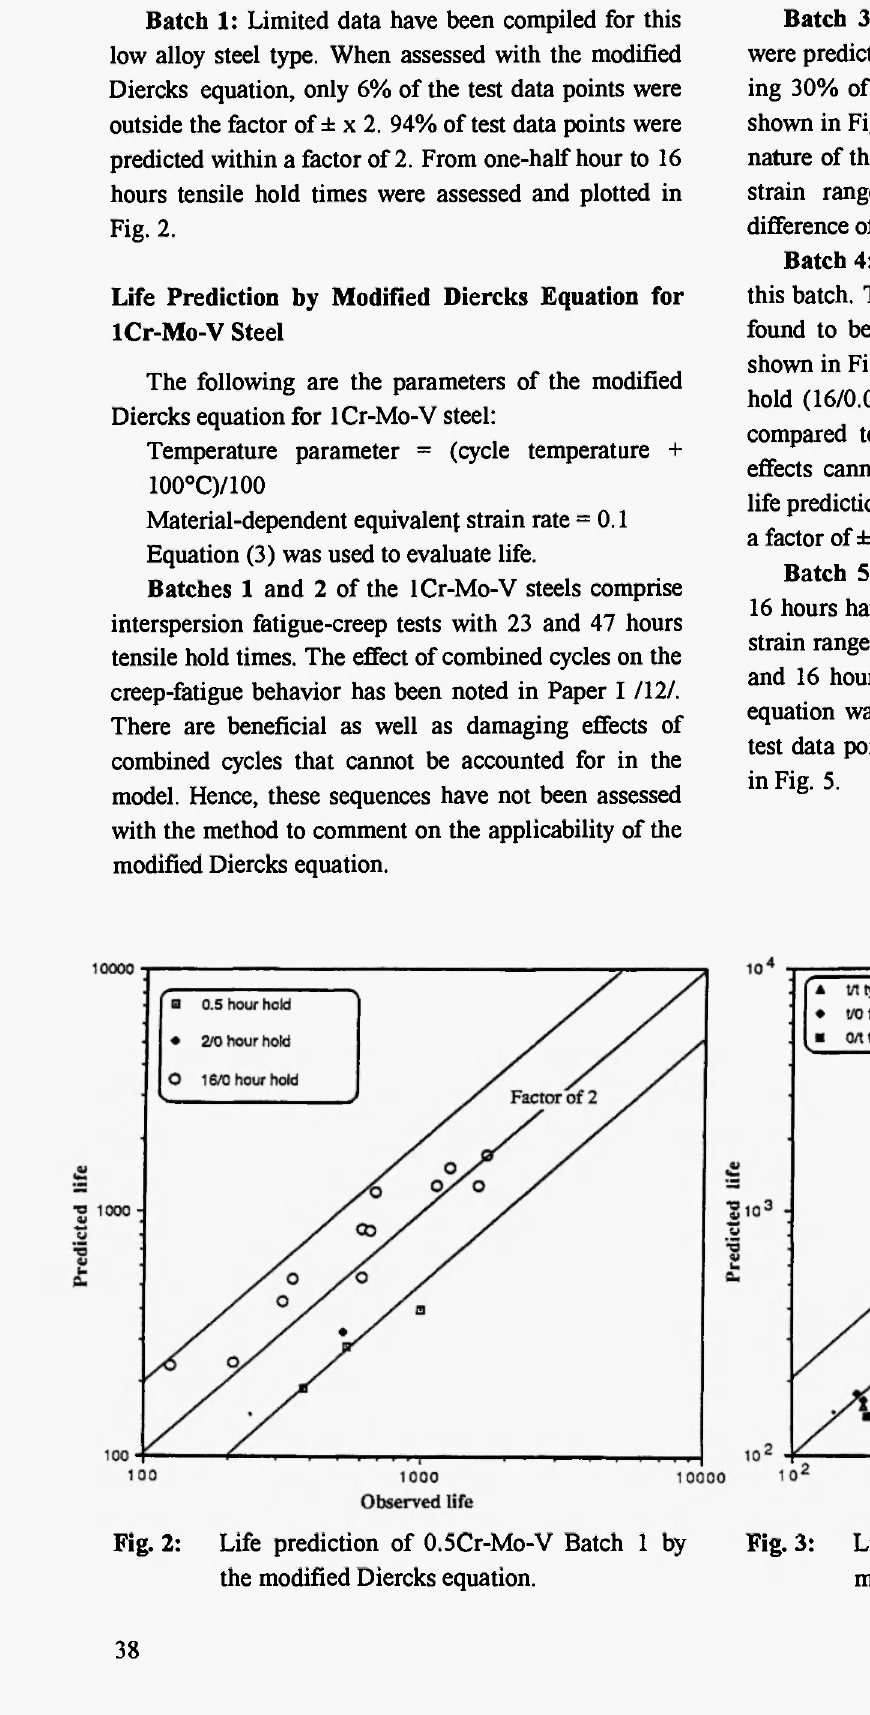
Fig. 2: Life prediction of 0.5Cr-Mo-V Batch 1 by Fig. 3: Life prediction of lCr-Mo-V Batch 3 by the the modified Diercks equation. modified Diercks